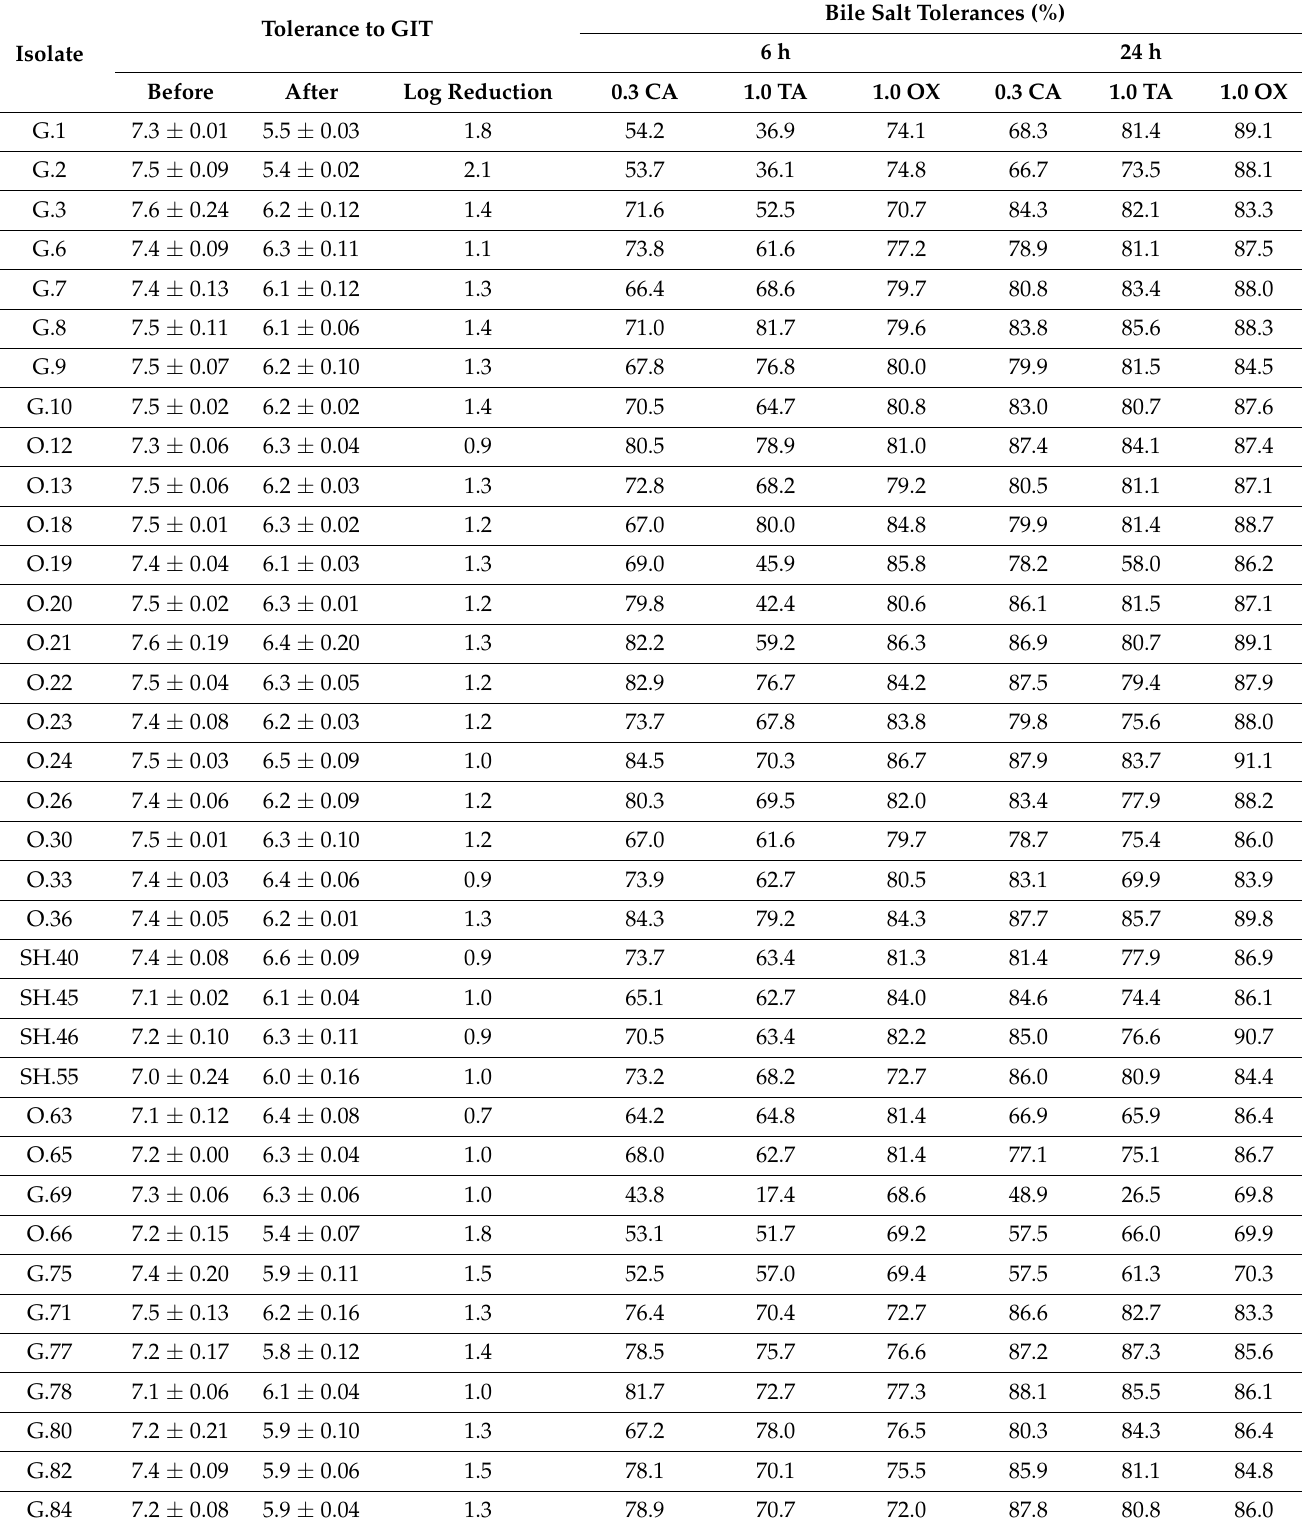
Table 1. In vitro digestion conditions and bile salt tolerances for 45 potential probiotic yeast